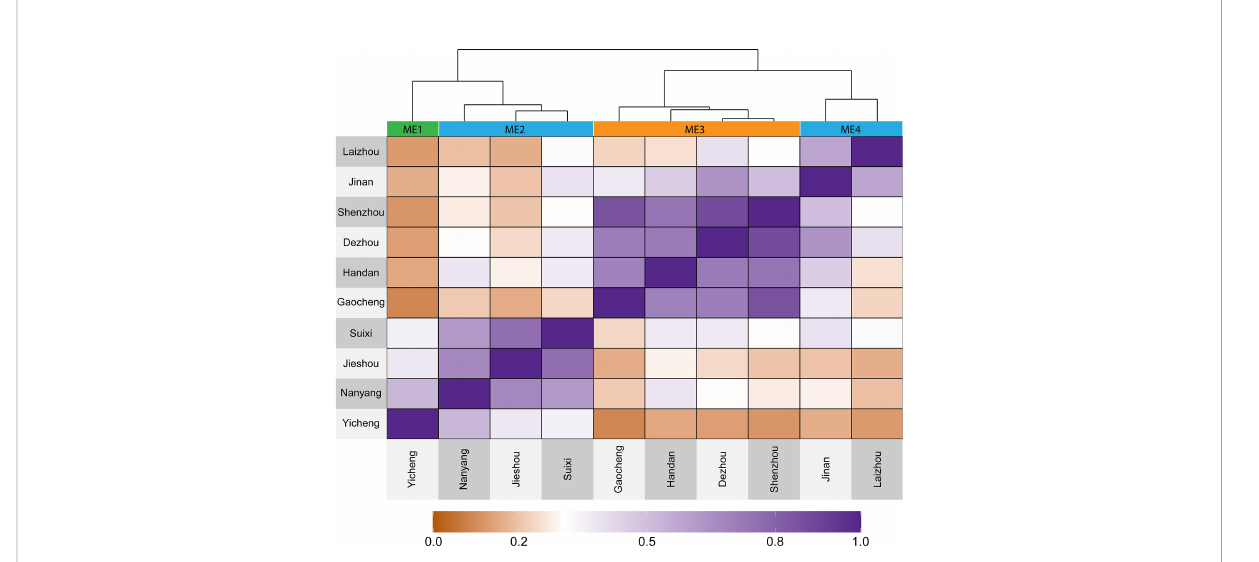
FIGURE 2 Heat map showing the delineated mega-environments considering the similarity based on 20 years of information for 19 environmental